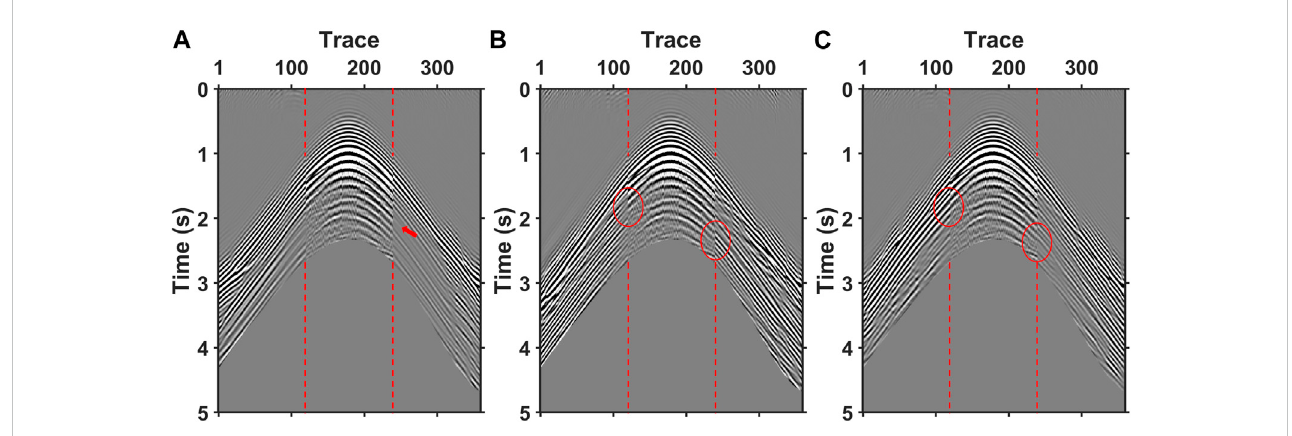
FIGURE 11 Syntheticdatageneratedusinginitialmodels (A) ,AEFWIresultsforOBSdata (B) andJ-AEFWIresults,comparedtotheobserveddata.Themiddleofeach image shows the fi eld data and the sides show the synthetic data, which are separated by red lines. The waveforms after multiples are